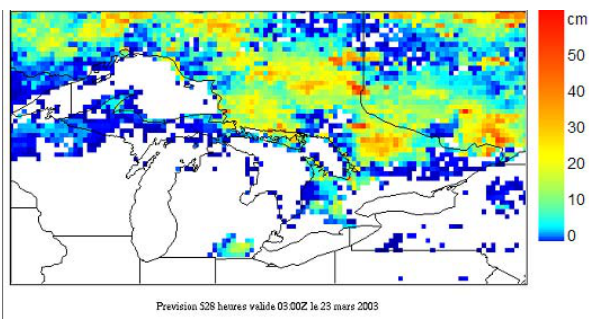
Fig. 19. ISBA snow depth prediction valid on 23 March